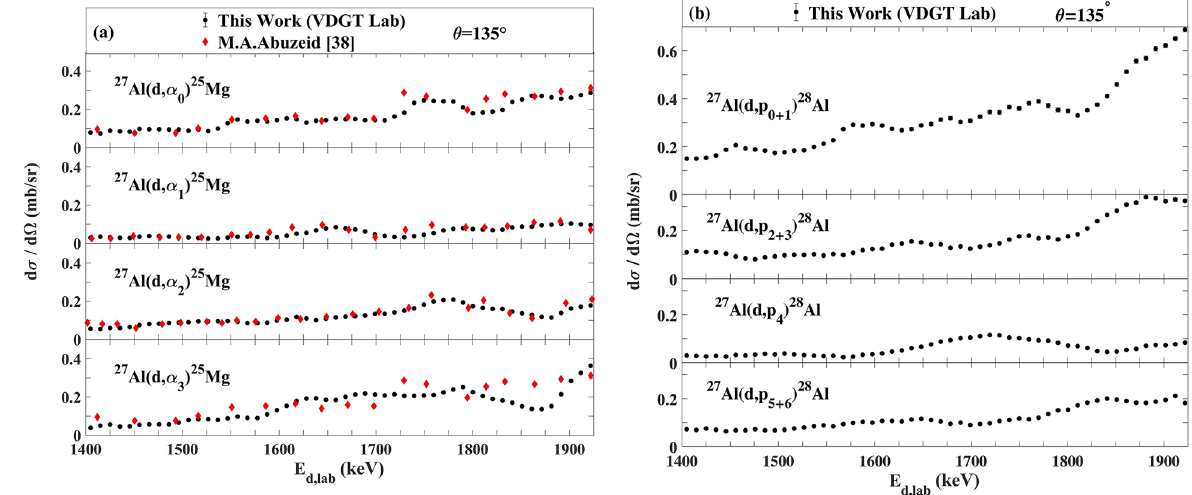
Figure 7. The differential cross sections measured at 135° at VDGT Lab in Tehran for the ( a ) 27 Al(d,α) 25 Mg reactions together with the data from 38 , and ( b ) 27 Al(d,p) 28 Al reactions. The estimated uncertainties from counting statistics are smaller than the plotted symbols.